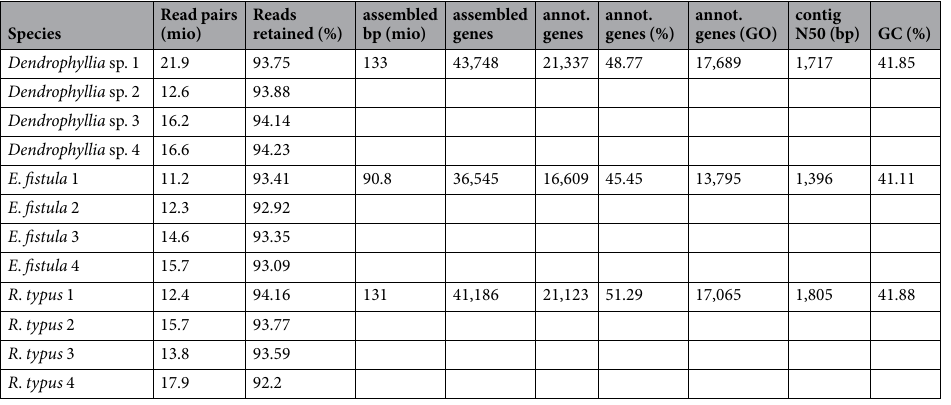
Table 1. Sequencing statistics and transcriptome assembly statistics for three deep-sea coral species from the Red Sea represented by four colonies